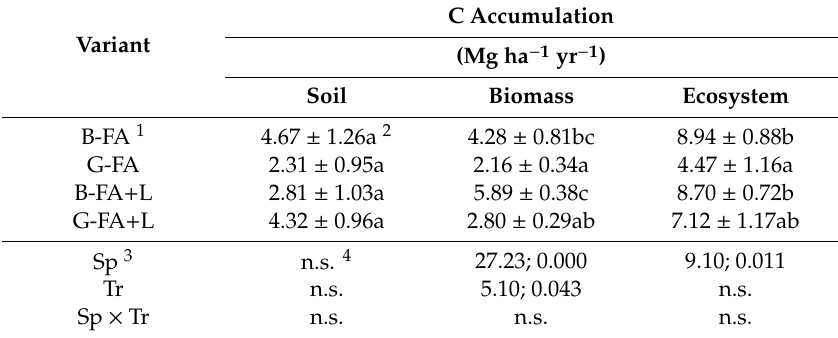
Table 4. Carbon accumulation in alder systems grown on combustion waste